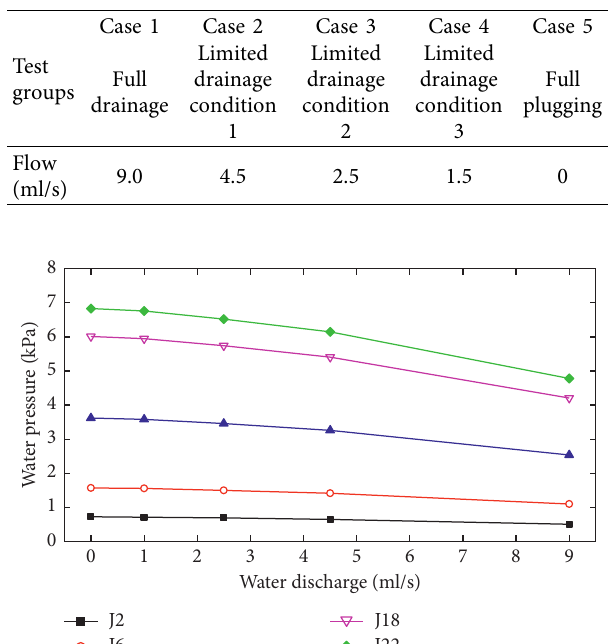
Table 5: Flow chart of each test group with 0.75kPa water head pressure.